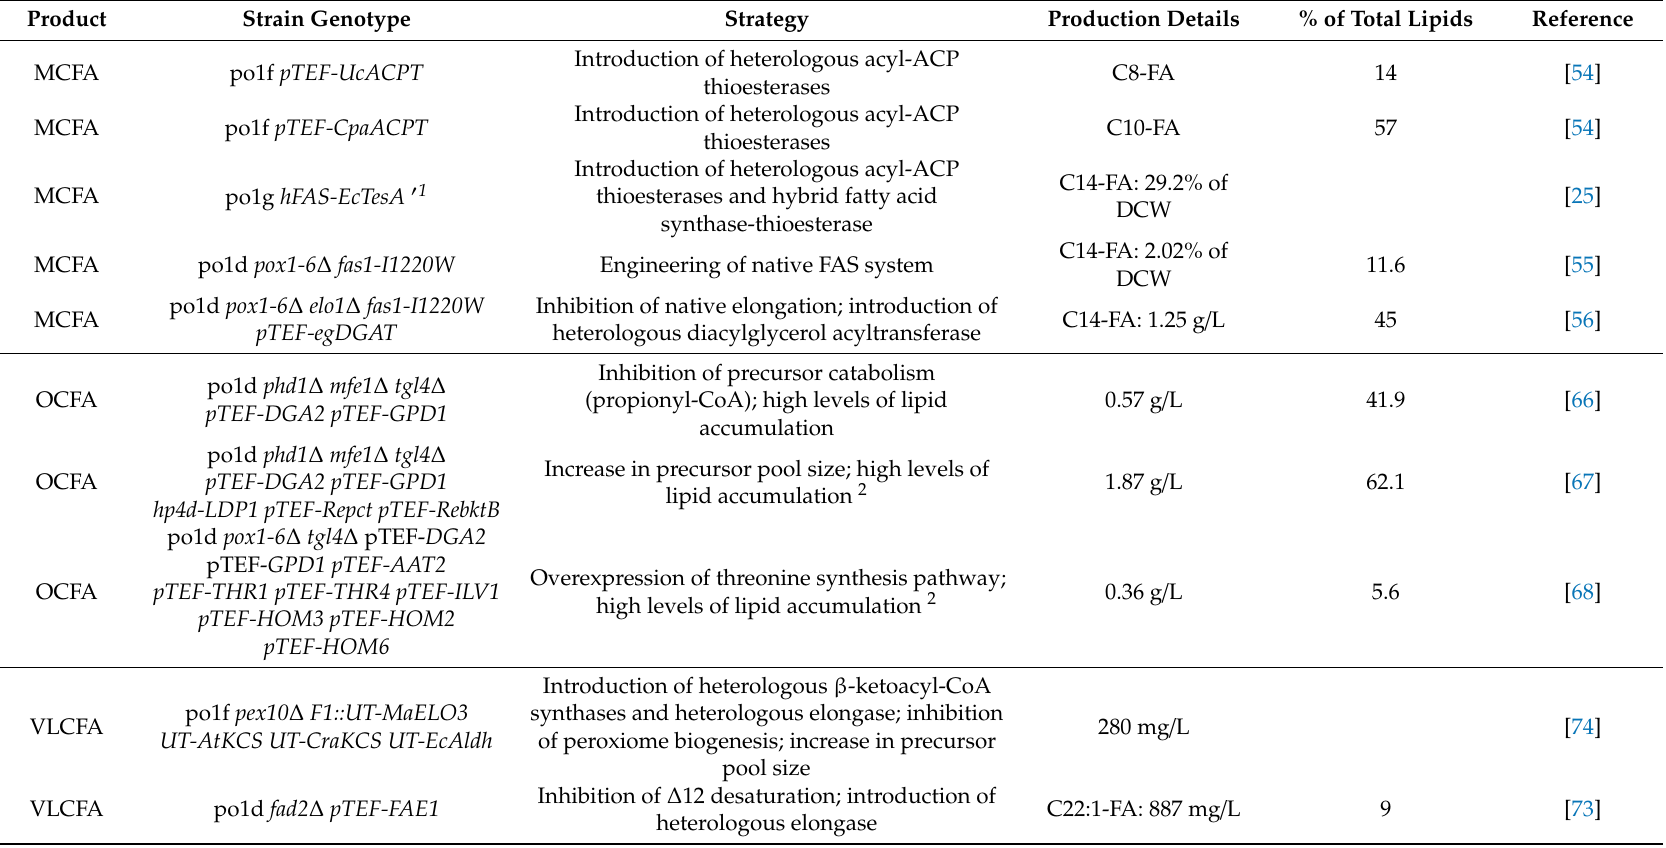
Table 1. The production of unusual lipids via metabolic engineering in Y. lipolytica